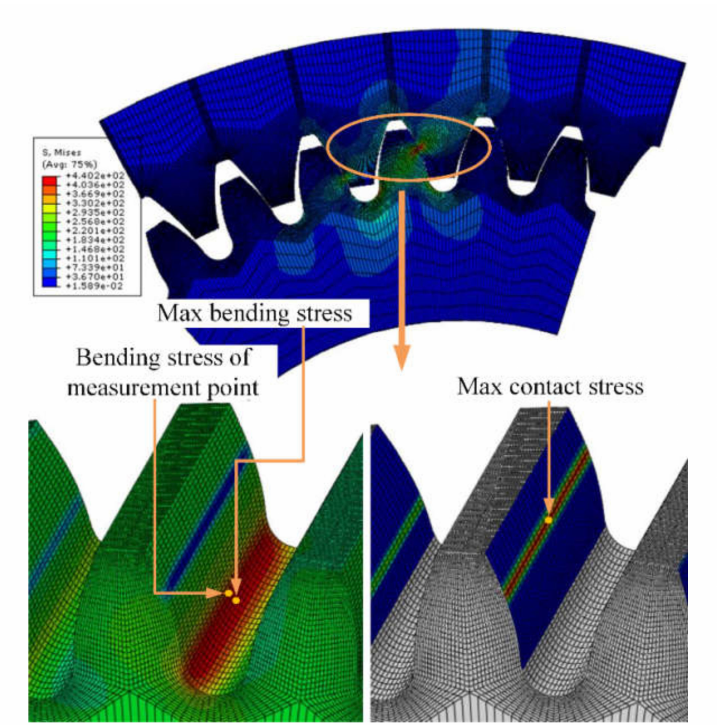
Figure 20. Bending and contact stress results of involute internal spur gear pair at 540 r/min and 600